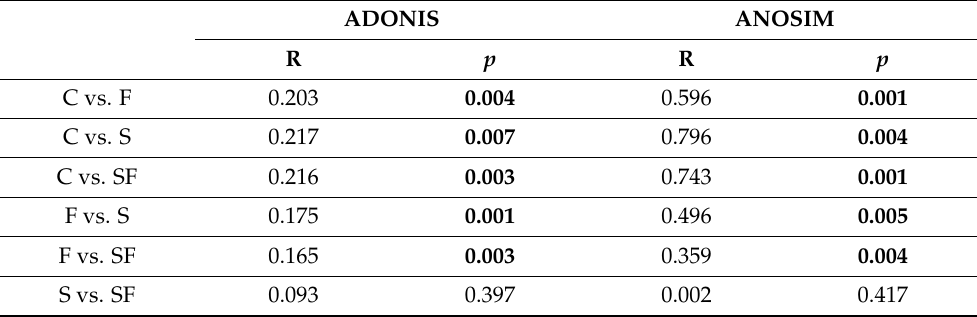
Table 2. ADONIS and ANOSIM tests for phytoplankton assemblage composition in different treatments. ADONIS